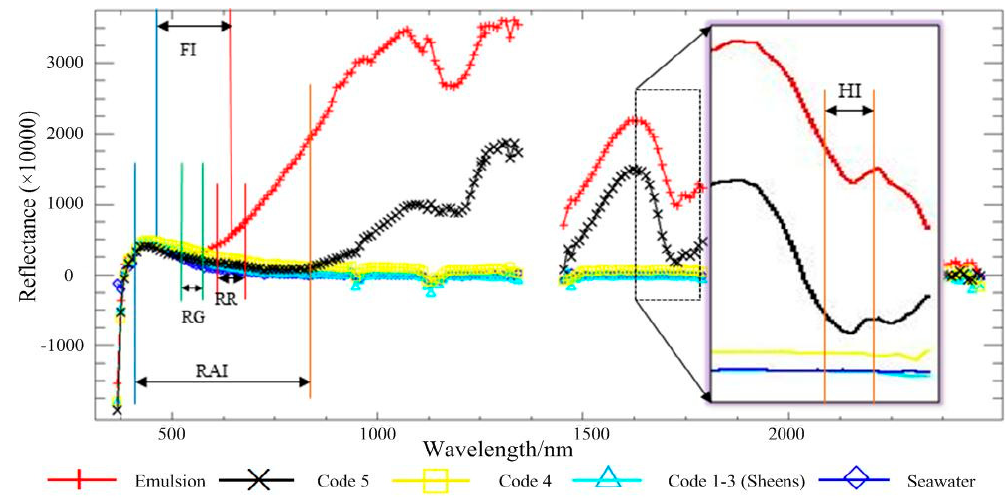
Figure 16. Bands used for spectral indices of hydrocarbons. Red, black, yellow, cyan, and blue lines represent emulsions, oil slicks of code 5, oil slicks of code 4, oil slicks of code 1–3, and seawater, respectively.